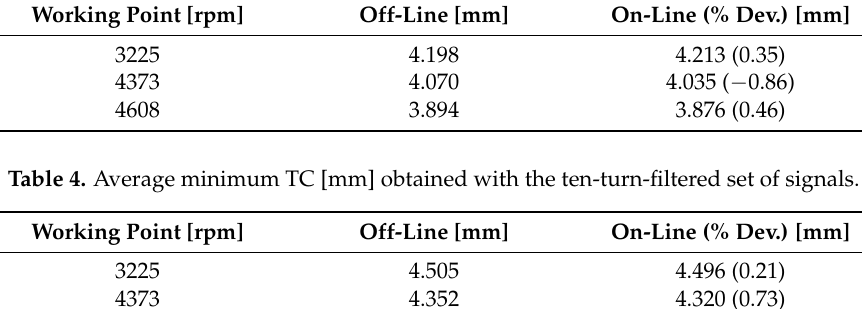
Table 3. Minimum TC [mm] obtained with the ten-turn-filtered set of signals. Working Point [rpm] Off-Line [mm]